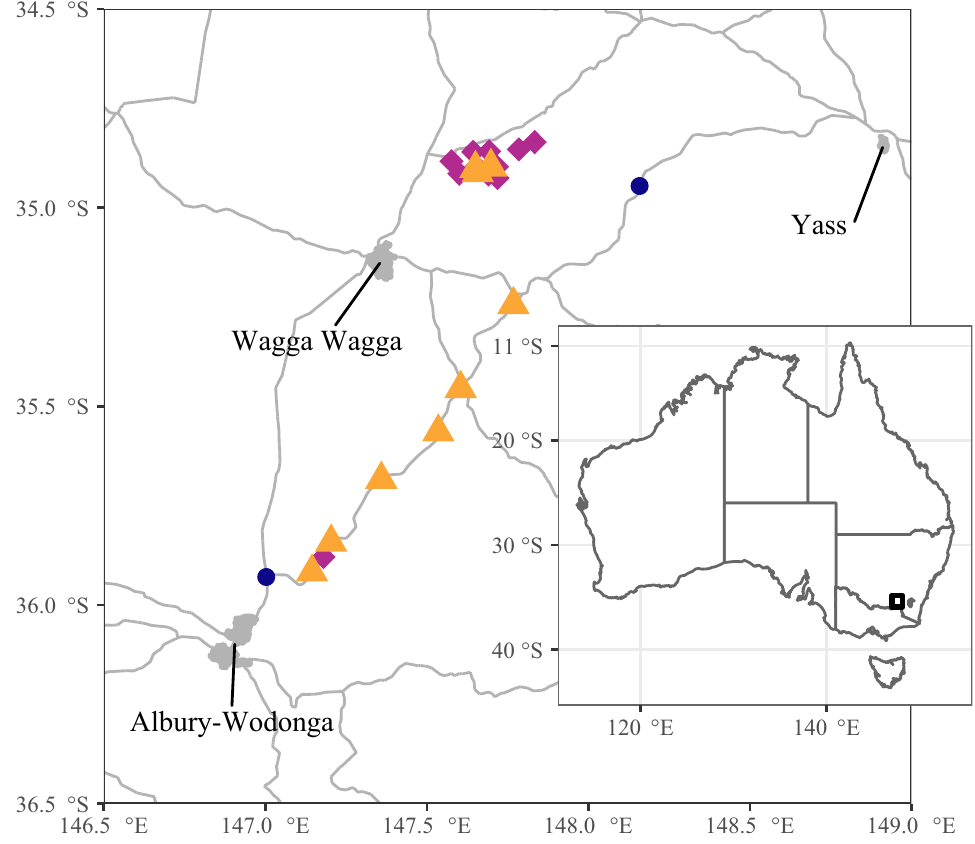
Figure 1. Map of the location of nest box survey sites. Triangles indicate sites that were used for calculating areal density of Apis mellifera colonies and modelling determinants of occupancy. Diamonds indicate sites used for occupancy modelling but not colony density calculations. Circles indicate sites that were included in the overall survey count but were not included in the occupancy modelling or density analyses. Figure created using R 39 with base map data from Geoscience Australia 71